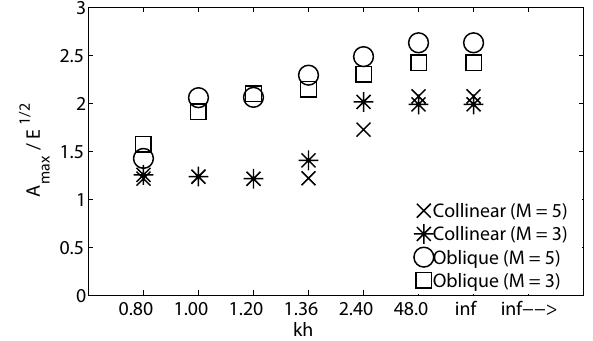
Fig. 7. Comparison with different